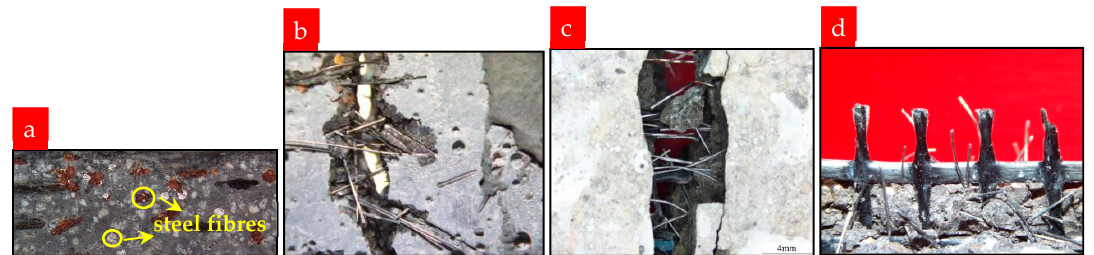
Figure 16. ( a ) Well ‐ distributed steel fibers; bridging capacity of steel fibers in cracks: ( b ) P0C1S1, ( c ) P0C2S1; ( d ) fracture surface of TRM with steel fibers.